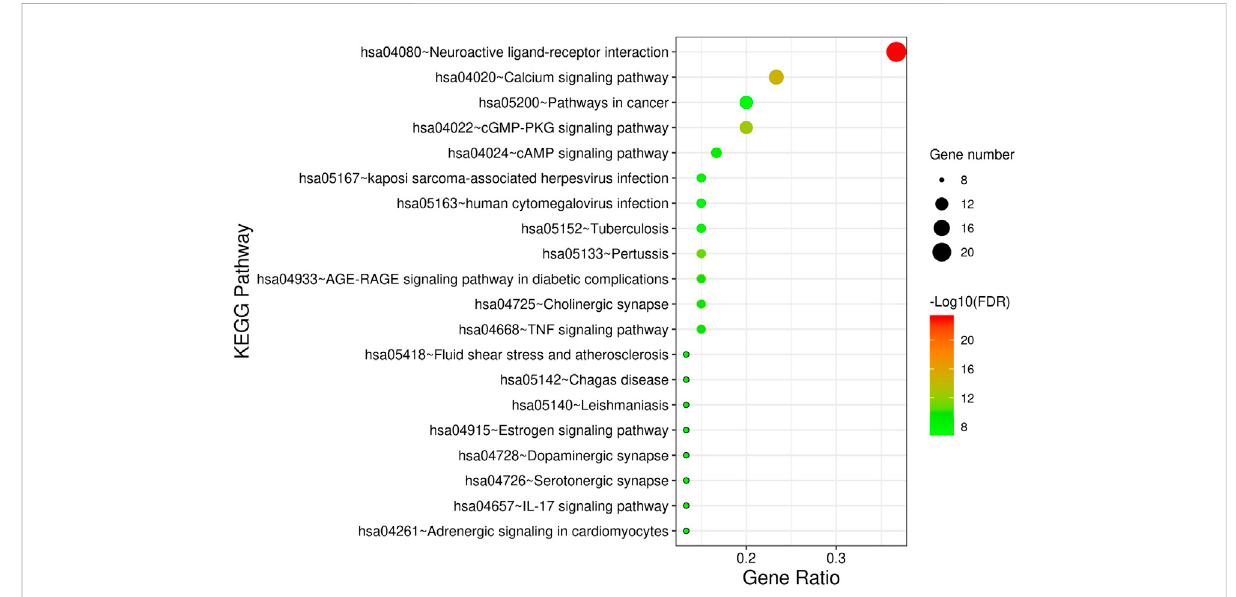
FIGURE 6 Bubble diagram of enrichment analysis of KEGG pathway of Ligusticum chuanxiong-Piper longum couplet medicines in the treatment of migraine (top